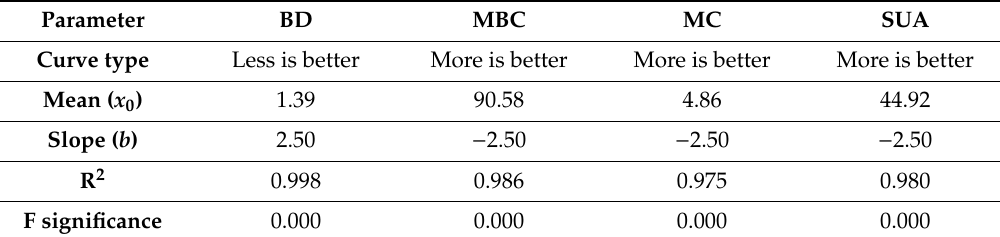
Table 6. Parameters for scoring